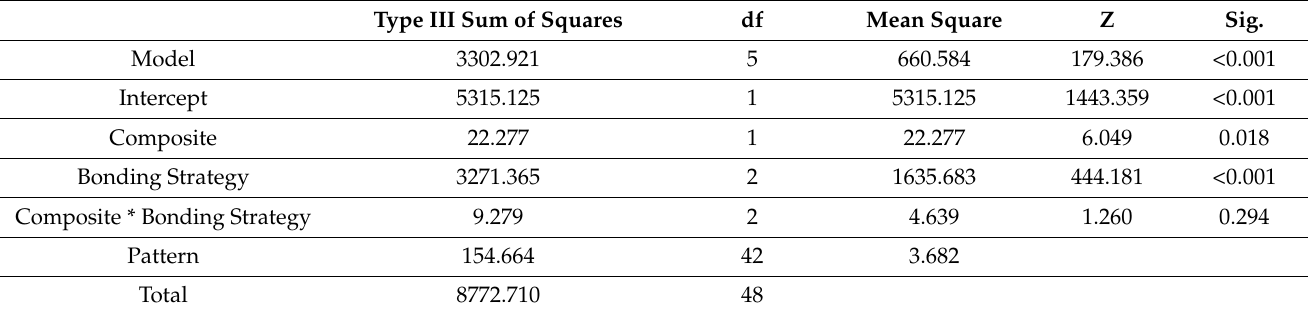
Table 4. ANOVA two-way output table, showing significance for both variables. Df represents degrees of freedom and Z .